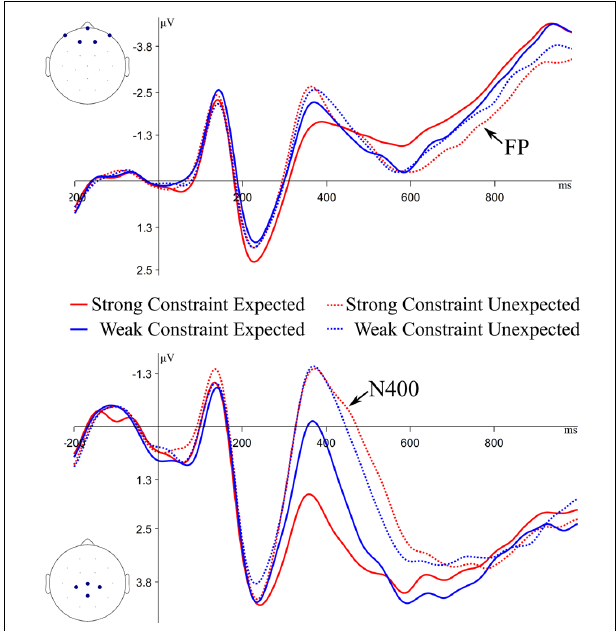
FIGURE 2 | Grand average event-related potential (ERP) waveforms for expected and unexpected endings to strongly and weakly constraining sentences at the frontal Cluster (top of figure) and central Cluster (bottom of figure) of channels. Negative is plotted up. FP, frontal positivity. FIGURE 3 | Grand average ERP waveforms to Match items during the